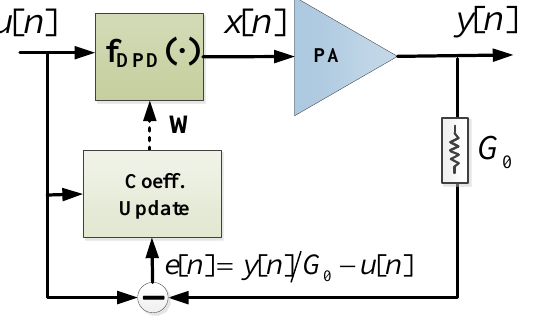
Figure 2. Closed-loop digital predistortion linearization: direct learning